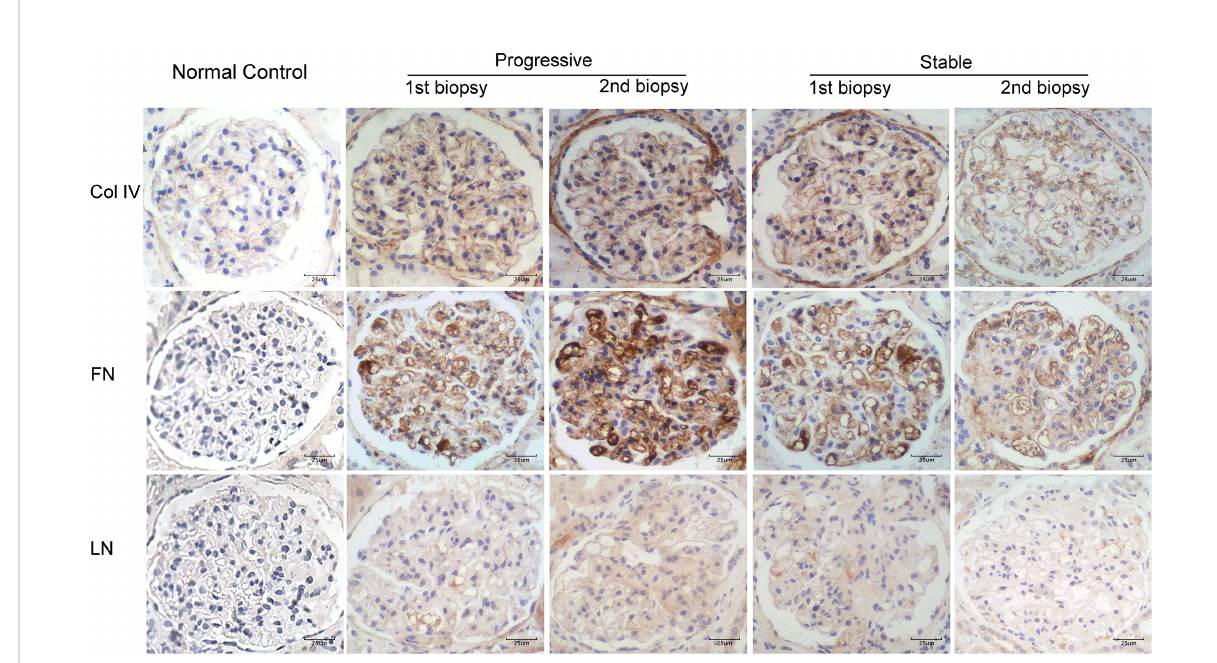
FIGURE 4 Immunohistochemical staining for Col IV, FN, and LN in patients with IgA nephropathy in the stable and progressive groups (×400). Col IV, collagen IV; FN, fi bronectin; LN,